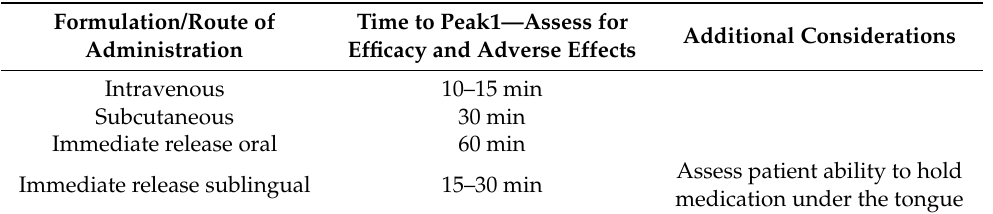
Table 3. Estimated opioid pharmacokinetic parameters pertinent to pain regimen monitoring and adjustment.